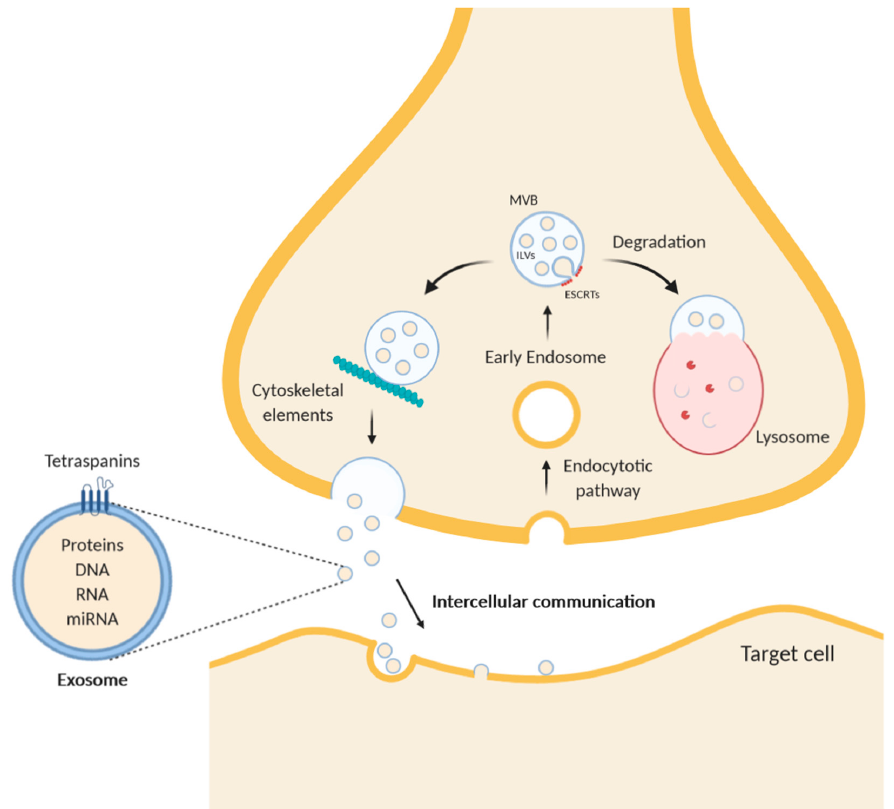
Figure 1. Schematic diagram of exosome trafficking in a neuron. While multivesicular bodies (MVBs) undergo a maturing process, the composition of the intraluminal proteins is gradually changed. The endosomal sorting complex required for transport (ESCRT) remodels the inner membrane of MVB to generate the intraluminal vesicles (ILVs), which represent exosomes inside the MVBs. After intracellular translocation mediated by cytoskeleton elements, such as F-actin, and microtubules, MVBs merge with the plasma membrane and undergo exocytosis. Alternatively, MVBs can fuse with lysosomes to degrade themselves. Exosomes contain in their lumen free proteins, RNA, microRNA, and DNA and are characterized by transmembrane proteins of the tetraspanins family.